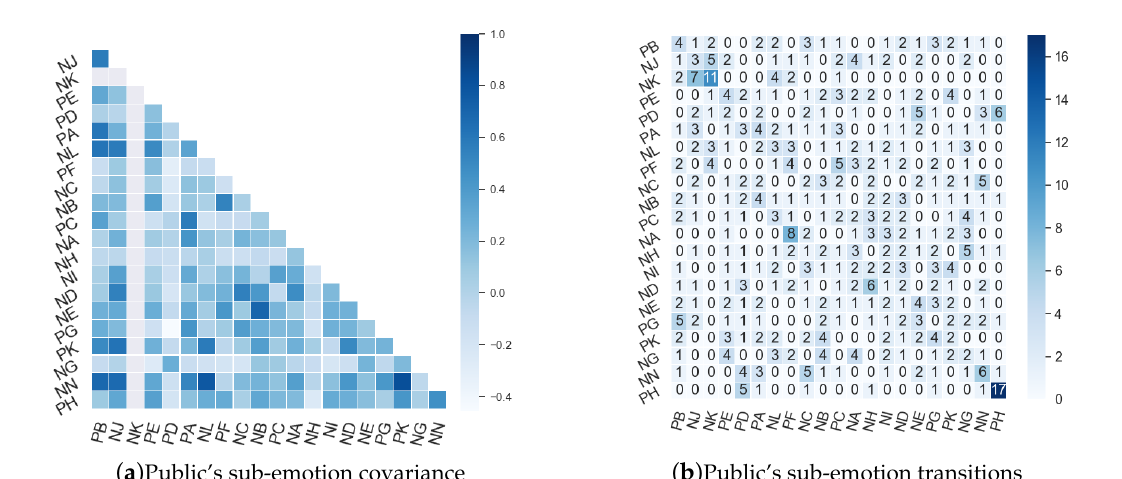
Figure A1. Public emotion covariance and transitions from 21 January 2020 to 17 February 2020, for 21 sub-emotions. PE = reassurance, PA = happiness, NJ = disappointment, PF = loneliness, NB = sadness, NH = guilt, PB = popularity, PD = respect, PG = belief, PK = desire, PH = praise, NA = anger, NK = jealousy, NL = doubt, ND = hate, NE = boredom, NN = reprimand, PC = surprise, NC = fear, NI = panic, NG =